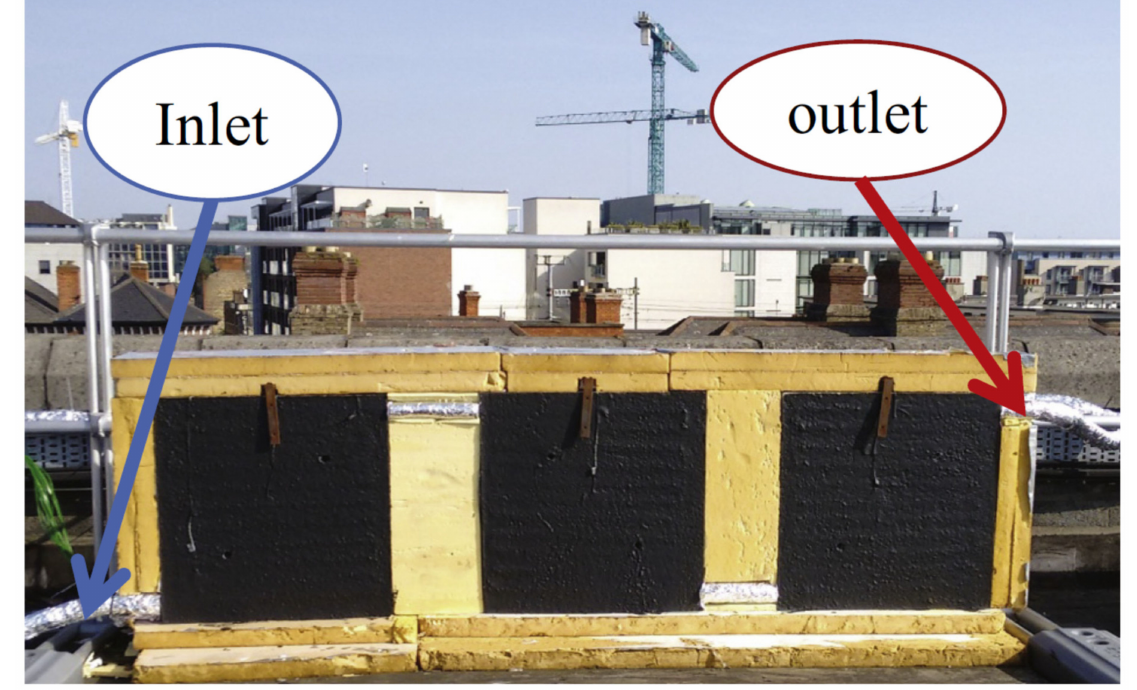
Figure 5. Construction of an experimental concrete solar collector in Ireland [56]. Reprinted from Solar Energy, Parametric investigation of concrete solar collectors for façade integration, Richard O’Hegarty, Oliver Kinnane, Sarah J. McCormack, 153 , 396–413, Copyright 2017, with permission from Elsevier.